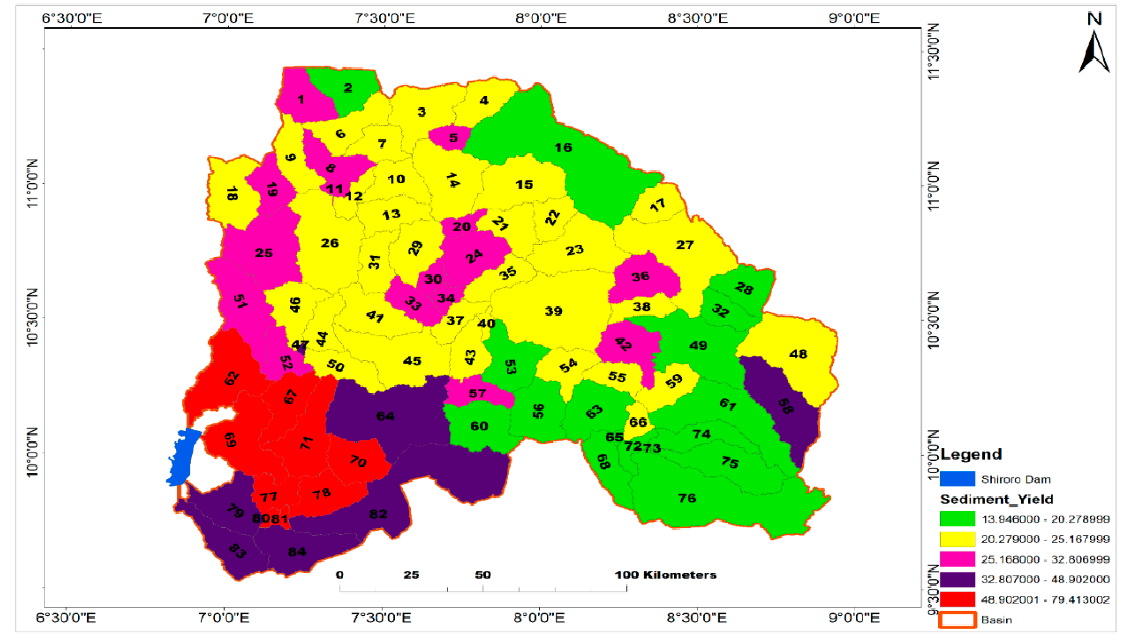
sification of the basin into five categories based on sediment yield generation. Land area in green has the lowest sediment yield while places in red colour generate the highest sediment